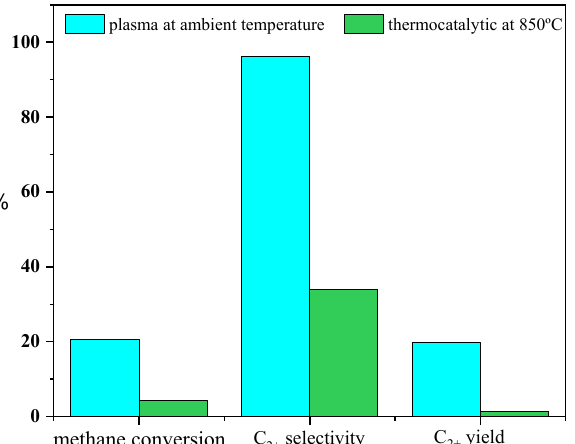
Figure 4. Catalytic performance of the MnTi catalyst with plasma and without plasma (flow rate: 60 mL/min, applied voltage: 100 V).